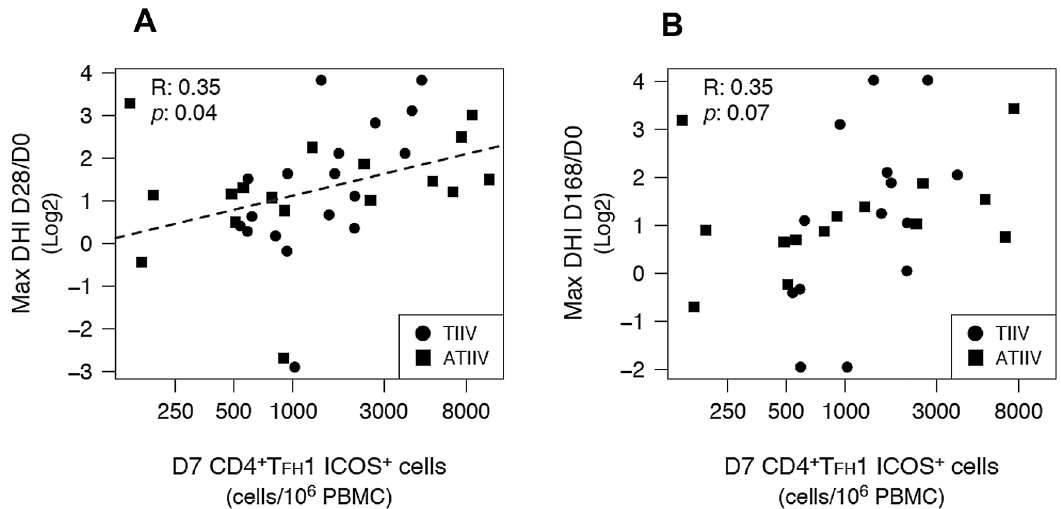
Fig 6. T FH 1 ICOS + cells predict functional antibody responses. Correlations between the number of total circulating CD4 + T FH 1 ICOS + cells and the maximum DHI responses observed across the three influenza strains represented in the vaccine, measured at (A) day 28 and (B) day 168 after immunizzation. Dashed lines represent the least squares regressions fit to the data. R: Pearson product-moment correlation coefficient. p : correlation-associated p value.